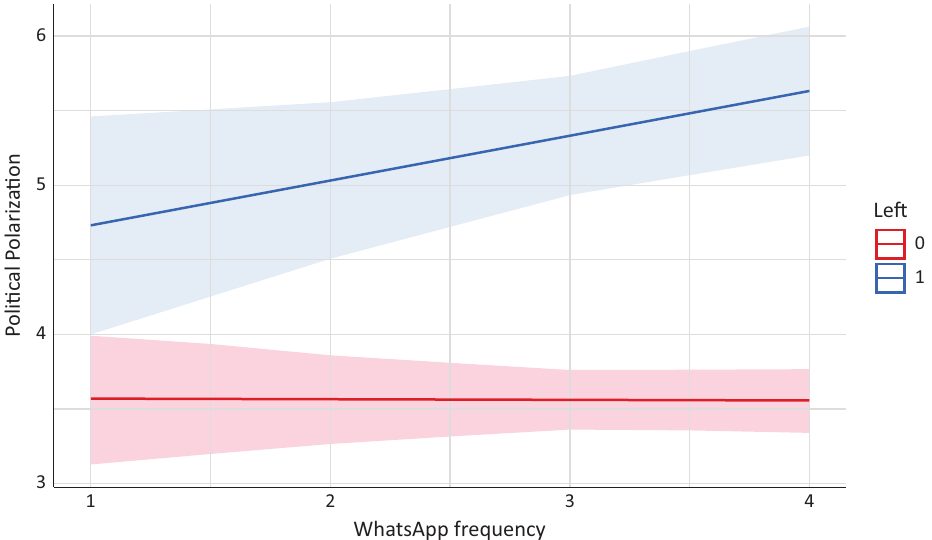
Figure 1. Predict values of affective polarization in Chile according to WhatsApp frequency and political position (left). Media and Communication, 2022, Volume 10, Issue 4, Pages